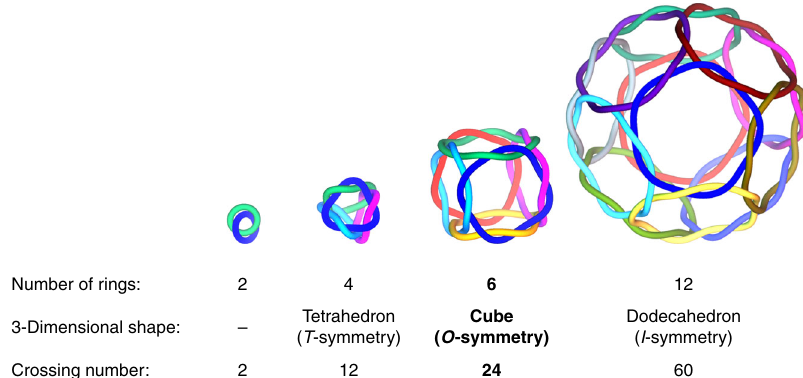
Fig. 2 Series of polyhedral peptide [ n ]catenanes. Topological diagrams of a [2]catenane, tetrahedral [4]catenane, cubic [6]catenane, and dodecahedral [12]catenane.